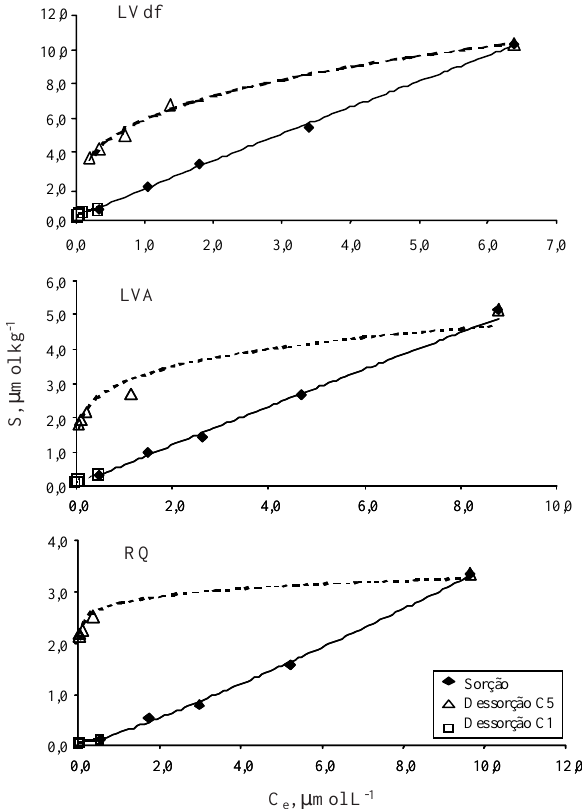
Figura 2. Isotermas de sorção (linha contínua) e dessorção (linhas tracejadas) de imazaquin em duas concentrações: C1 (0,67 µmol L -1 ) e C5 (10,72 µmol L -1 ) em amostras de um Latossolo Vermelho distroférrico (LVdf), um Latossolo Vermelho-Amarelo (LVA) e um Neossolo Quartzarênico (RQ).